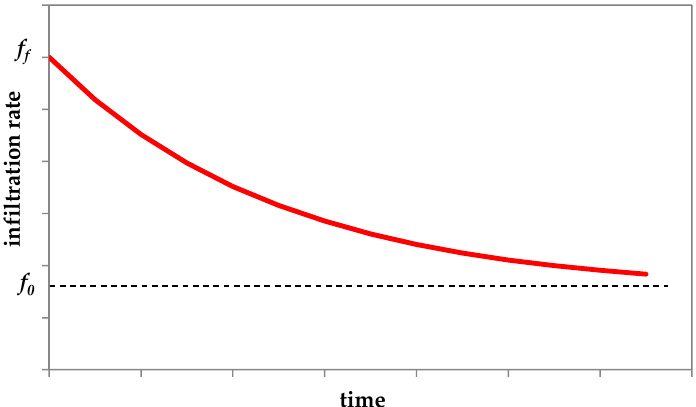
Figure 2. Graphical representation of the Horton empirical equation.